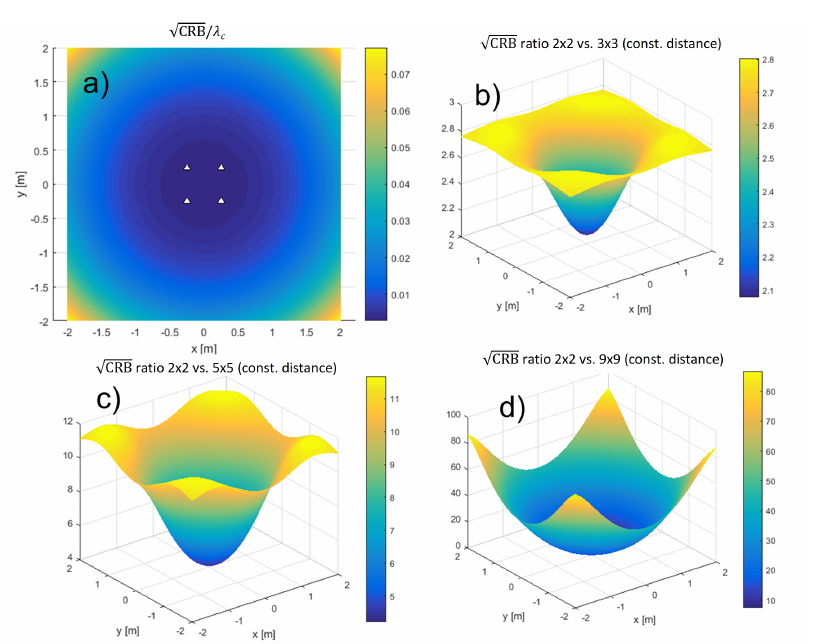
Figure 6. The CRBs for different array sizes in the constant antenna distance scenario. The square root of the CRB, normalized by the carrier wavelength, for the 2 × 2 array is shown in ( a ). The ratios of 2 × 2 on one hand and 3 × 3, 5 × 5, and 9 × 9 on the other are shown in ( b ), ( c ), and ( d ), respectively.